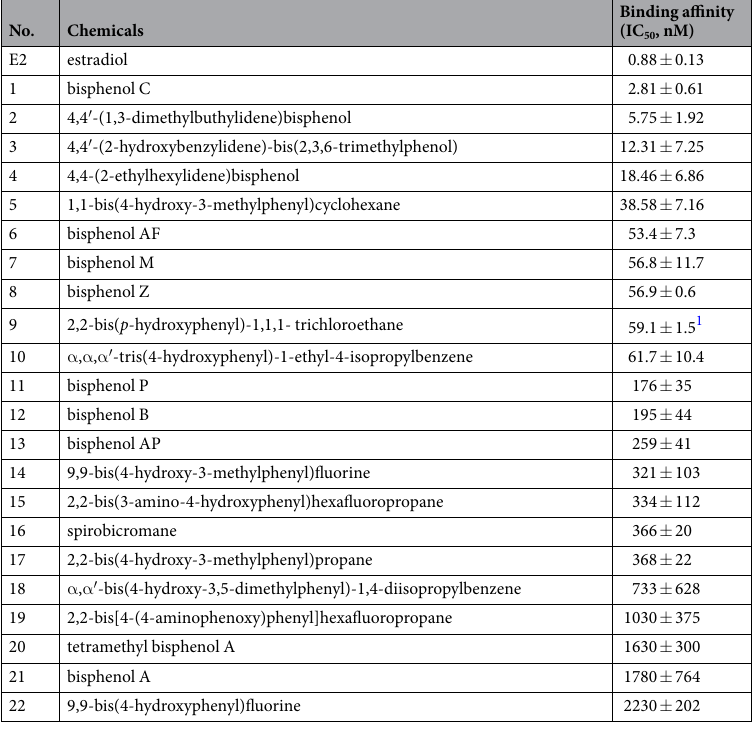
Table 1. The receptor binding affinity (mean ± SE) of BPA derivatives for estrogen receptor by using [ 3 H]17 β - oestradiol as a radioligand.